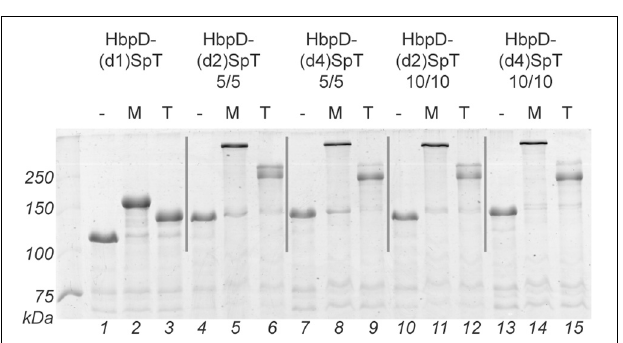
FIGURE 2 | Spy ligation to the Hbp display platform containing an internal SpyTag. OMVs containing the Hbp display platform with a SpyTag at different positions (domain 1, 2, or 4) between either five amino acid long linkers (5/5) or ten amino acid long linkers (10/10) were incubated with SpC-MBP (M) or with SpC-TrxA (T). Protein ligation was analyzed by SDS-PAGE with Coomassie staining. Identical amounts of OMV material (OD 660 units) were loaded in each lane. Below the gel image lane numbers are